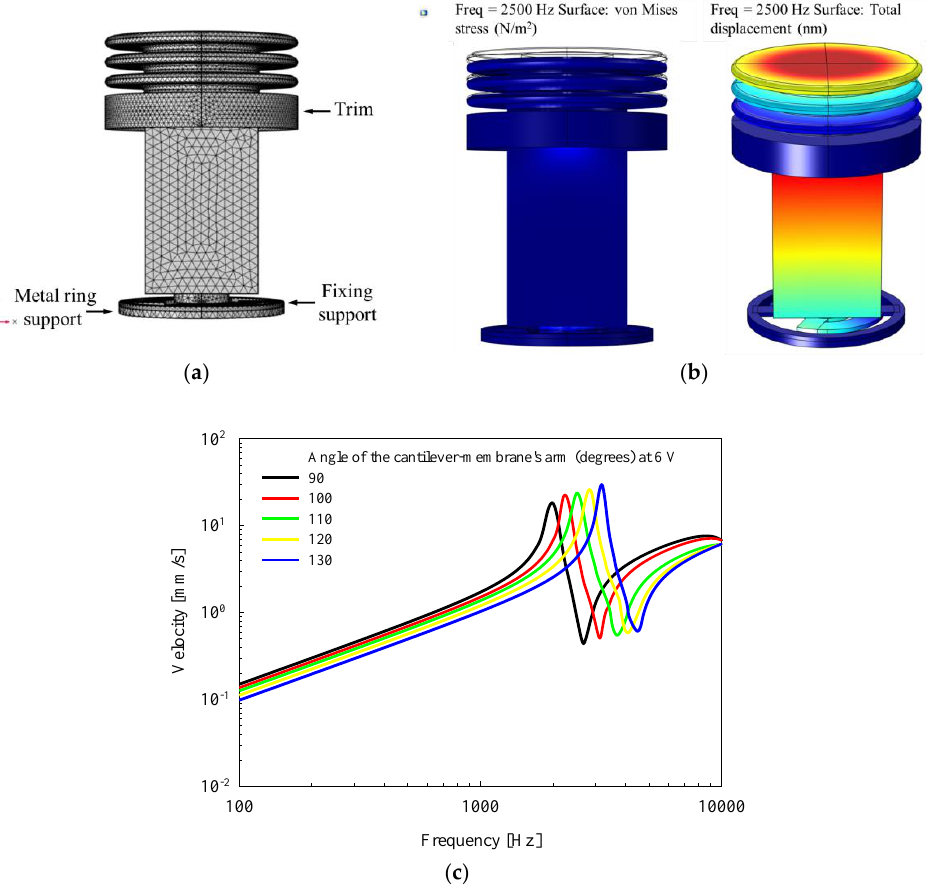
Figure 5. ( a ) Mesh modeling for modal analysis; ( b ) von Mises stress distribution (right), and total displacement distribution (left) of the actuator at 2.5 kHz; ( c ) vibrational characteristics according to the angle of the arm of the cantilever membrane.